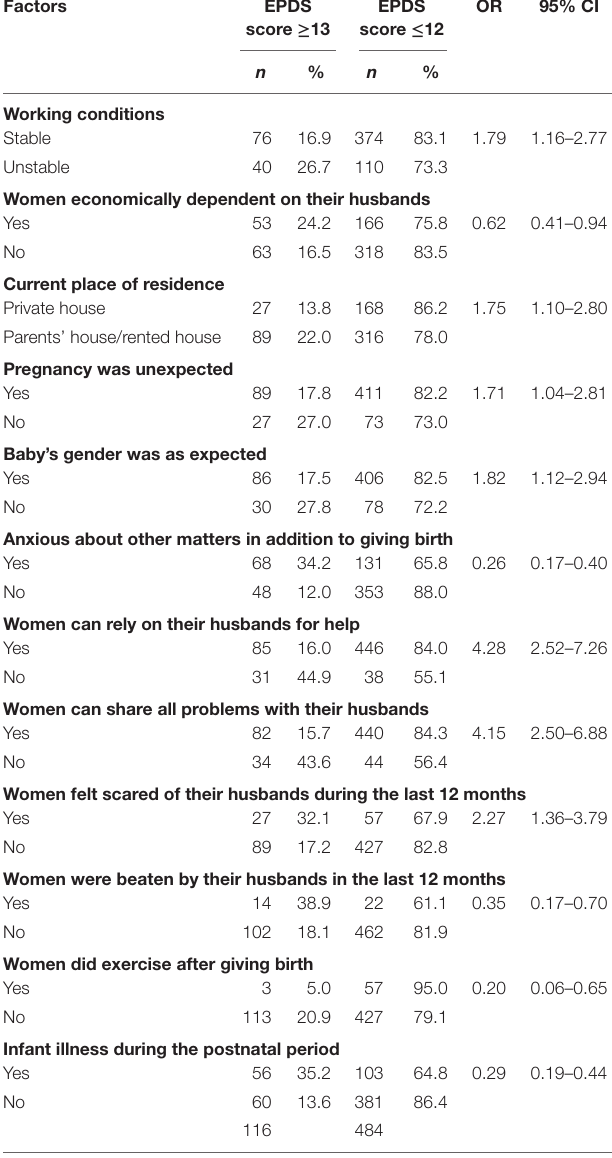
Table 3 | results of multivariate logistic regression analysis to examine factors associated with postpartum depression based on ePDs.